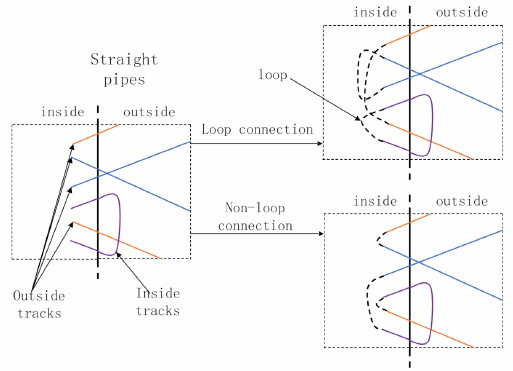
Figure 4. Schematic of loop